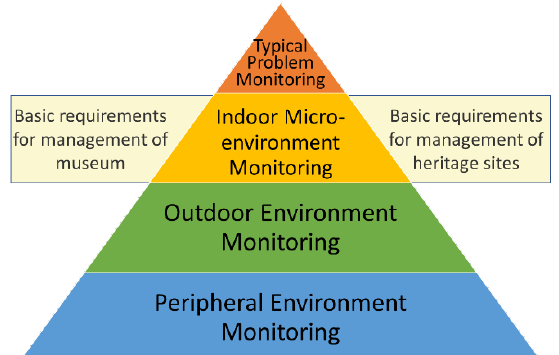
Figure 1. Environmental monitoring system of the Forbidden